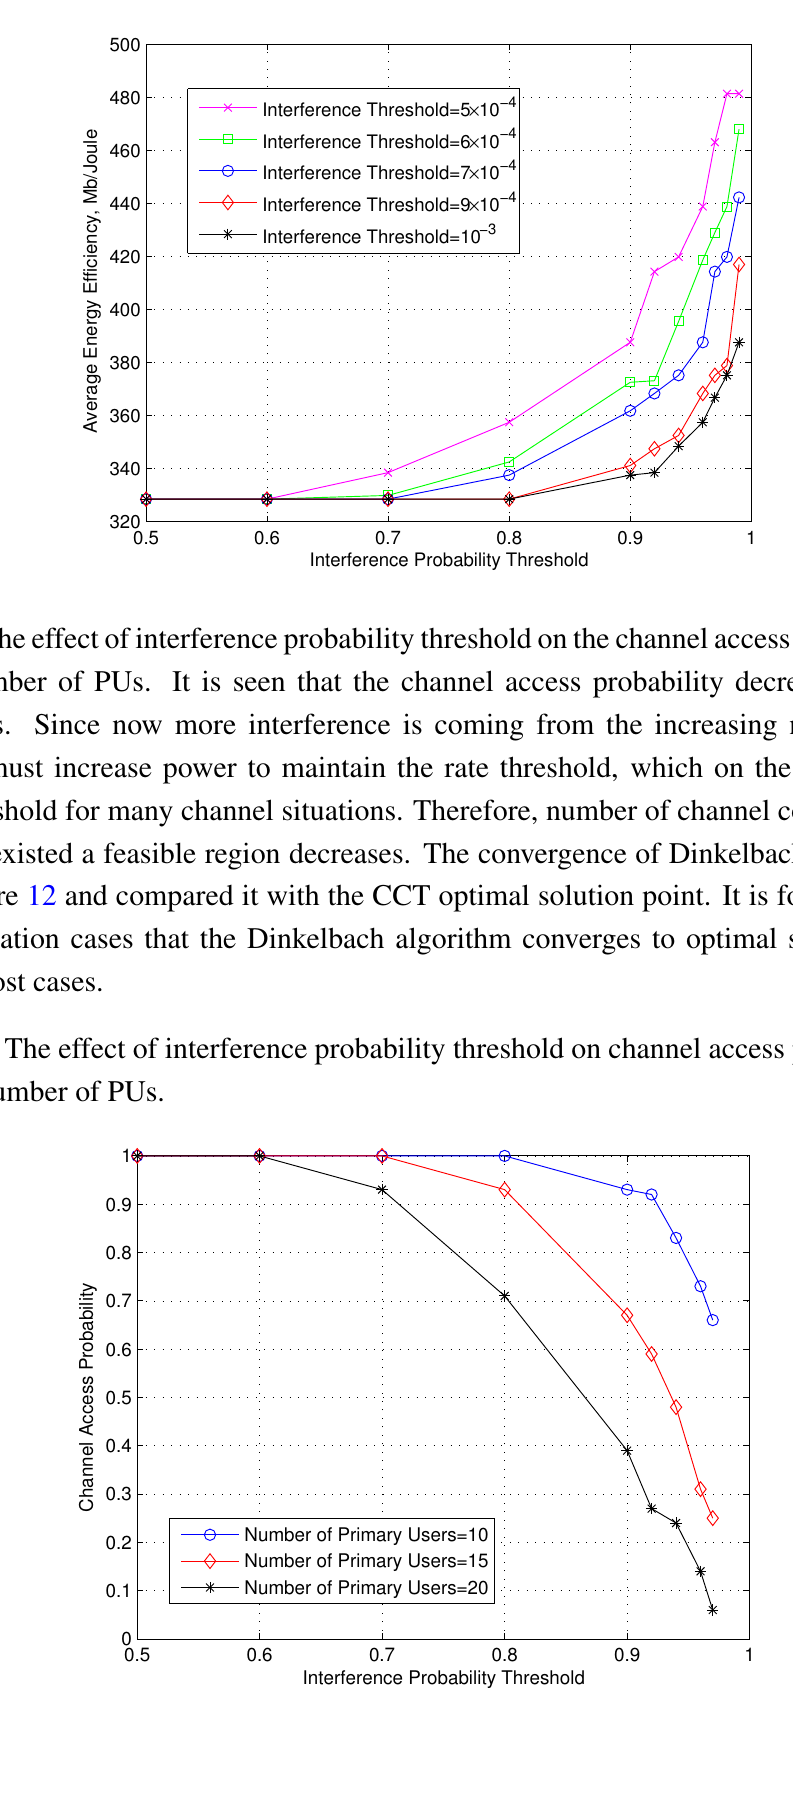
Figure 10. Average energy efficiency vs. interference probability threshold for different interference thresholds.